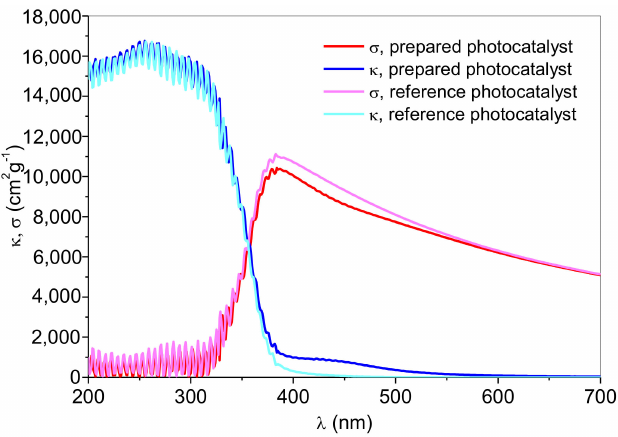
Figure 10. Absorption ( κ ) and scattering ( σ ) coefficients of prepared Ag-doped anatase powder compared to reference sample without Ag [24], as a function of